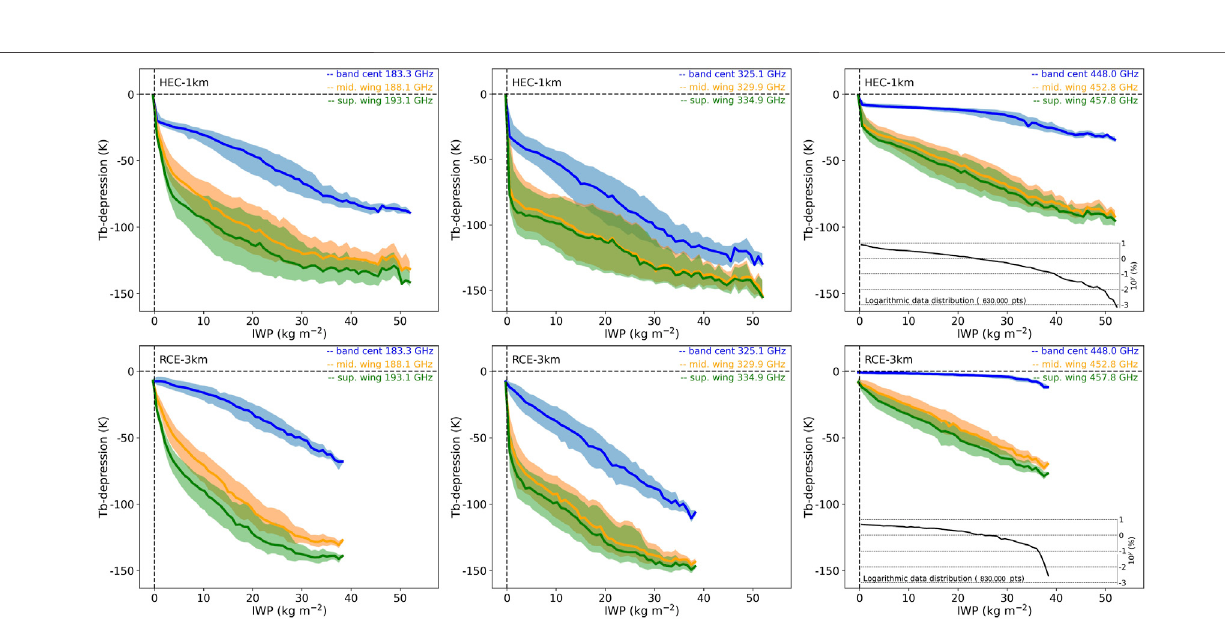
FIGURE 2 | Tb depression as a function of IWP for (top) HEC and (bottom) RCE and for (from left to right) 183.3, 325.1, and 448.0 GHz bands. The median (bold lines) and the interquartile ranges (shadings) are shown for the band center (blue), the mid-wing (+5 GHz, orange), and the wing (+10 GHz, green) of the upper band. In the right column, the insert shows the data distribution in logarithmic